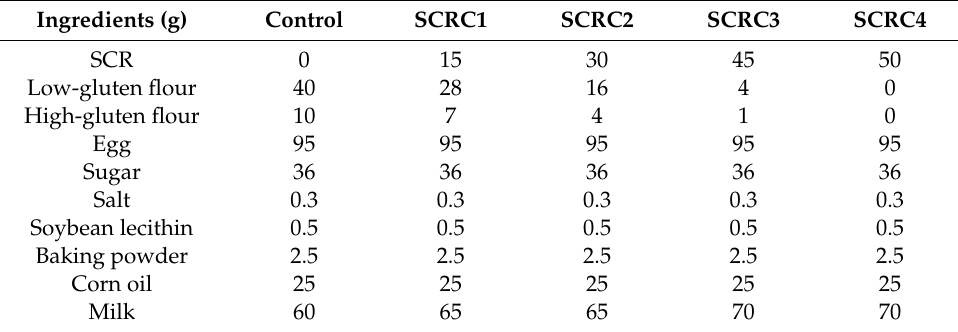
Table 1. Formulation of sweet corn residue (SCR)